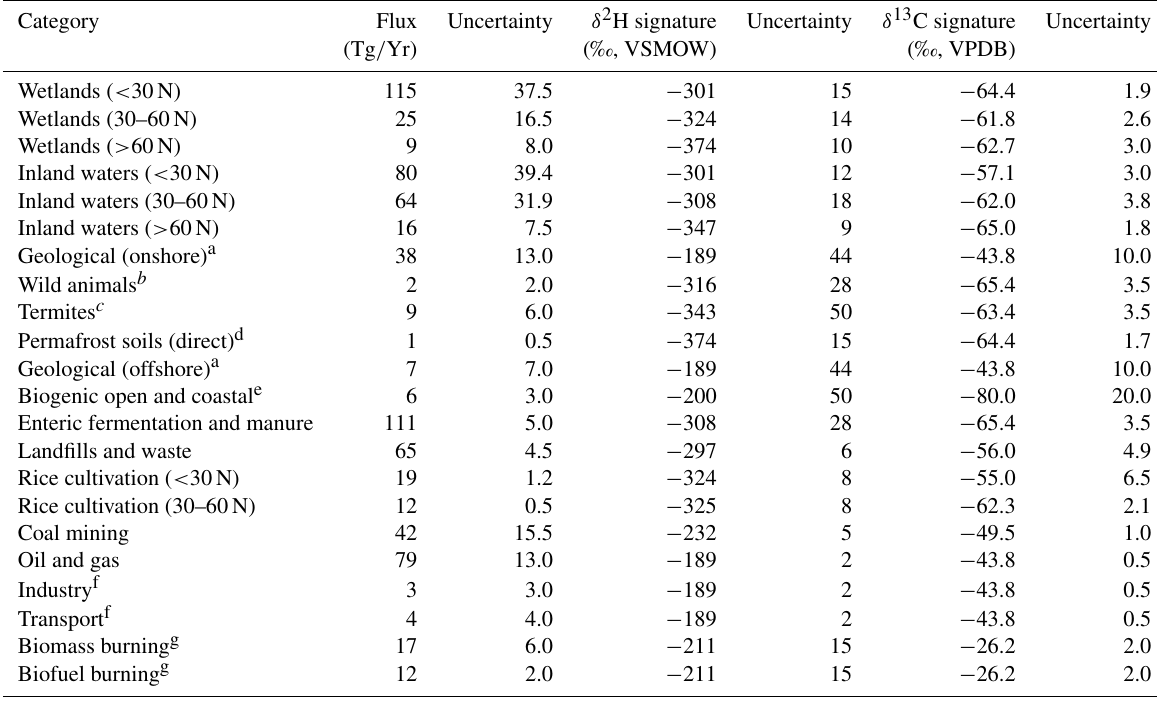
Table 1. Estimates of source-specific fluxes, δ 2 H–CH 4 , and δ 13 C-CH 4 and their uncertainties, used in mixing models and Monte Carlo